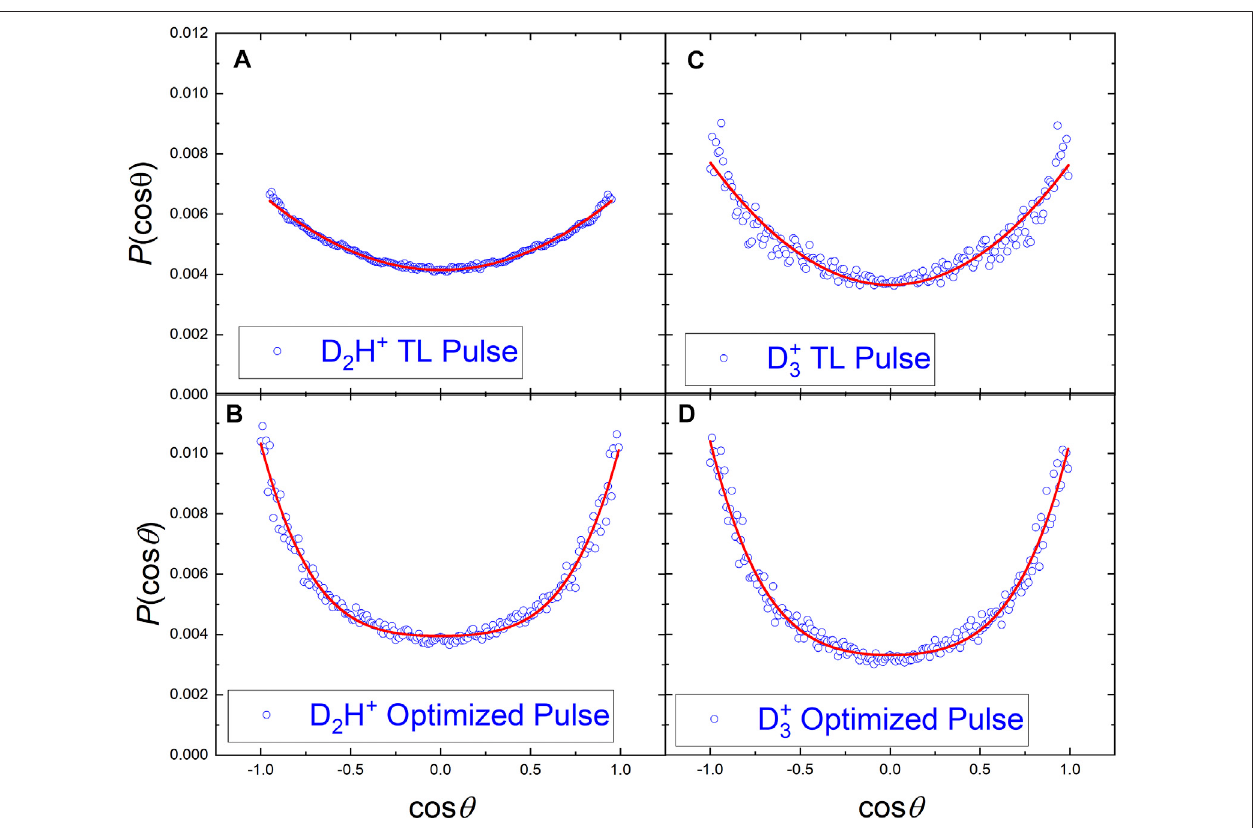
FIGURE 7 | The angular distributions of D 2 H + and D + 3 from VMI measurements of D 3 C-CH 3 dissociation. (A) D 2 H + fragments from a TL pulse. (B) D 2 H + fragments produced from pulses optimized to increase the D 2 H + :D + 3 ratio. In the right column are the same distributions for D + 3 fragments by the (C) TL and (D) optimized pulses. The molecular ions forming the angular distributions are from within the areas on interest shown in Figure 2 . The angle θ is between the laser polarization direction and the fragment dissociation direction. The solid lines in each panel are fi ts of the data to a Legendre polynomial in cos θ . The fi t coef fi cients are shown in Table 2 .